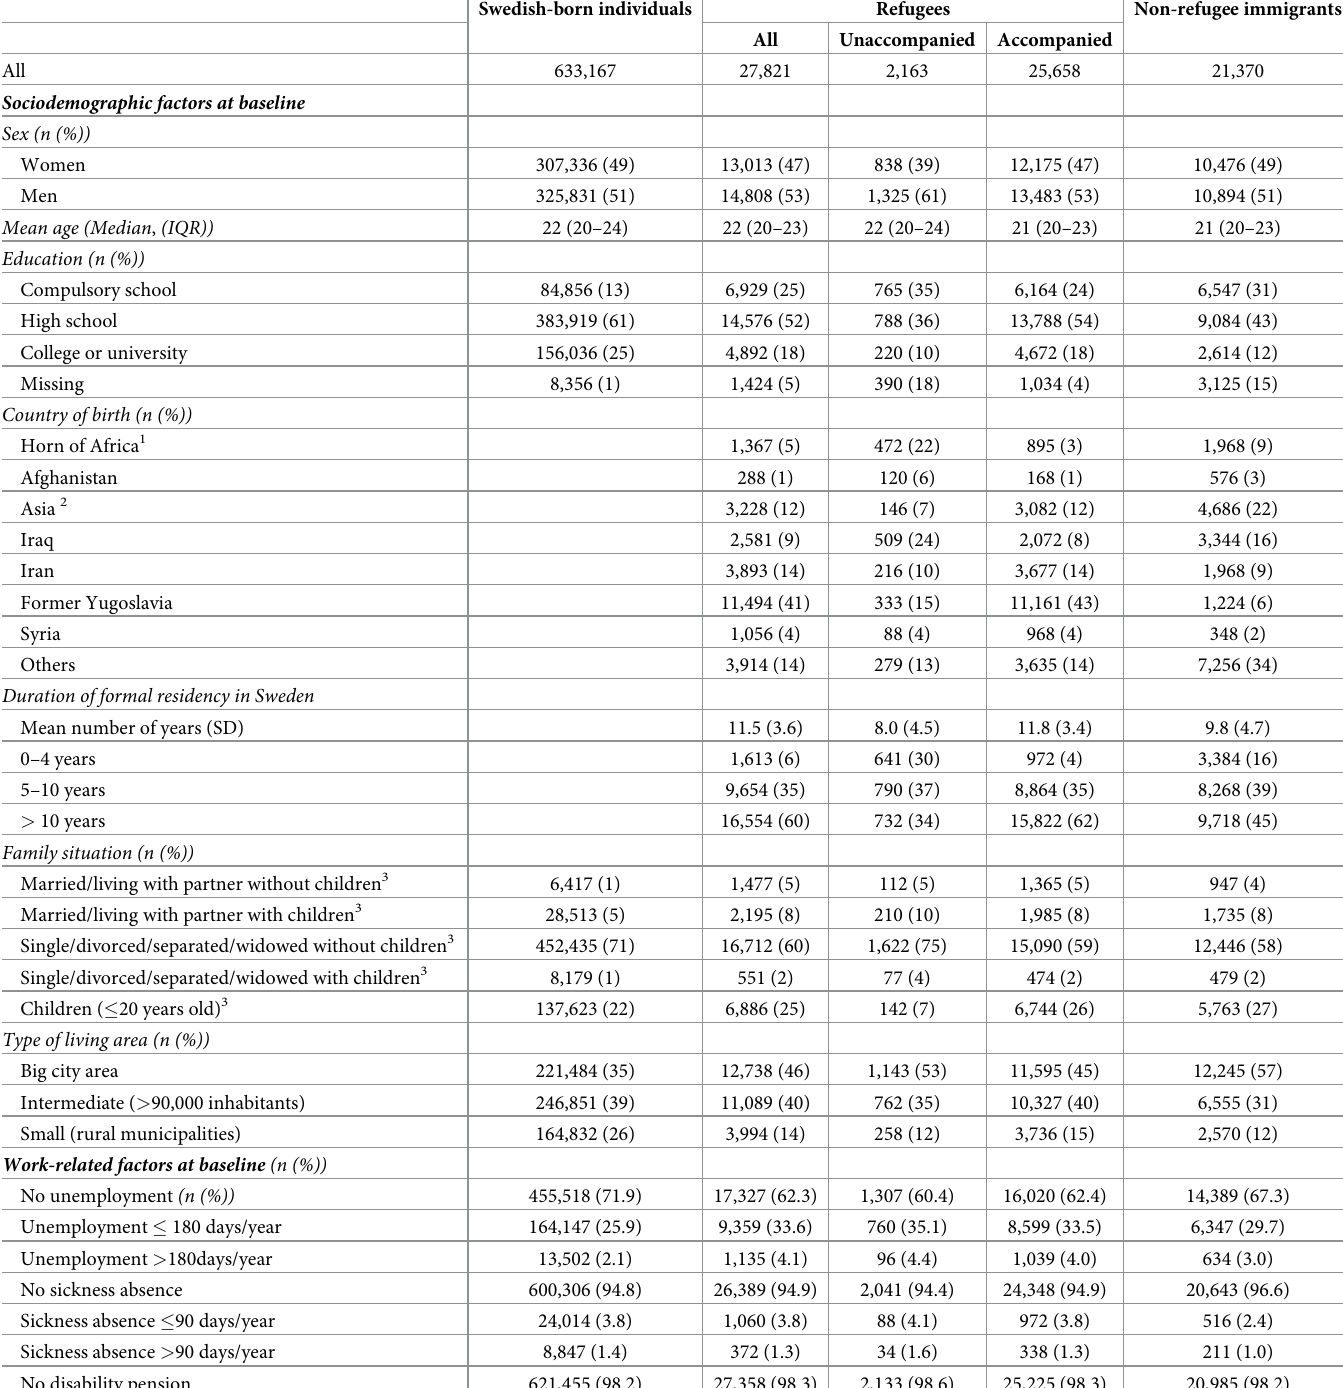
Table 1. Baseline characteristics, by refugee status, in individuals aged 19–25 years old residing in Sweden in